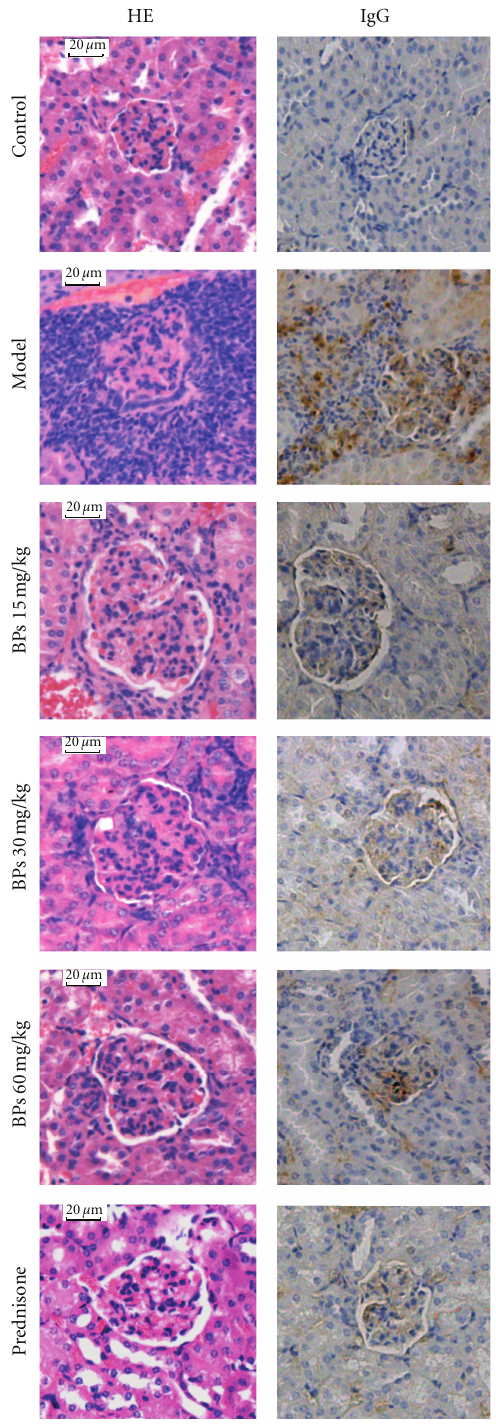
Figure 5: Haematoxylin and eosin-stained and immunohistochemistry of kidney sections. Light microscopy was 200x. Section of a BALB/c group mouse: normal kidney sections (HE, IgG). Section of a vehicle-treated model mouse: glomerular sclerosis, tubular atrophy, and increased infiltrating leukocytes (HE), a patchy dense immunoperoxidase indicative of IgG deposition (IgG). Section from 15, 30, 60mg · kg − 1 · day − 1 BP- and prednisone-treated mouse: mild mesangial cell proliferation (HE), less IgG deposition